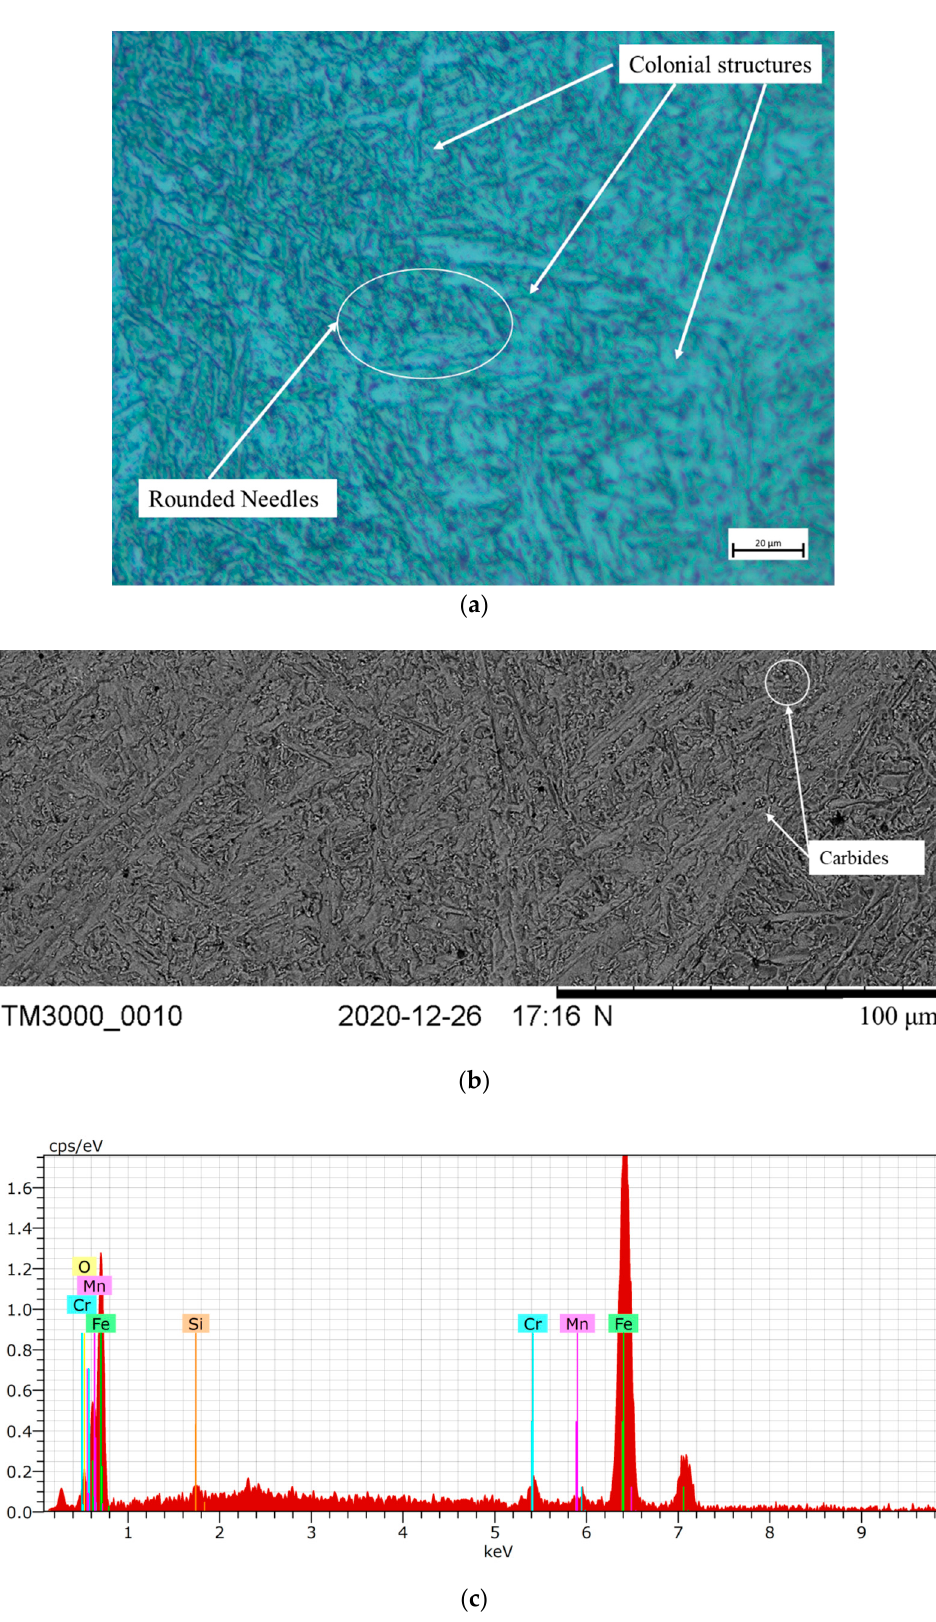
Figure 7. Microstructure analysis of the weld zone subjected to PWHT. ( a ) Optical microscopy, ( b ) SEM image, and ( c ) EDX analysis.